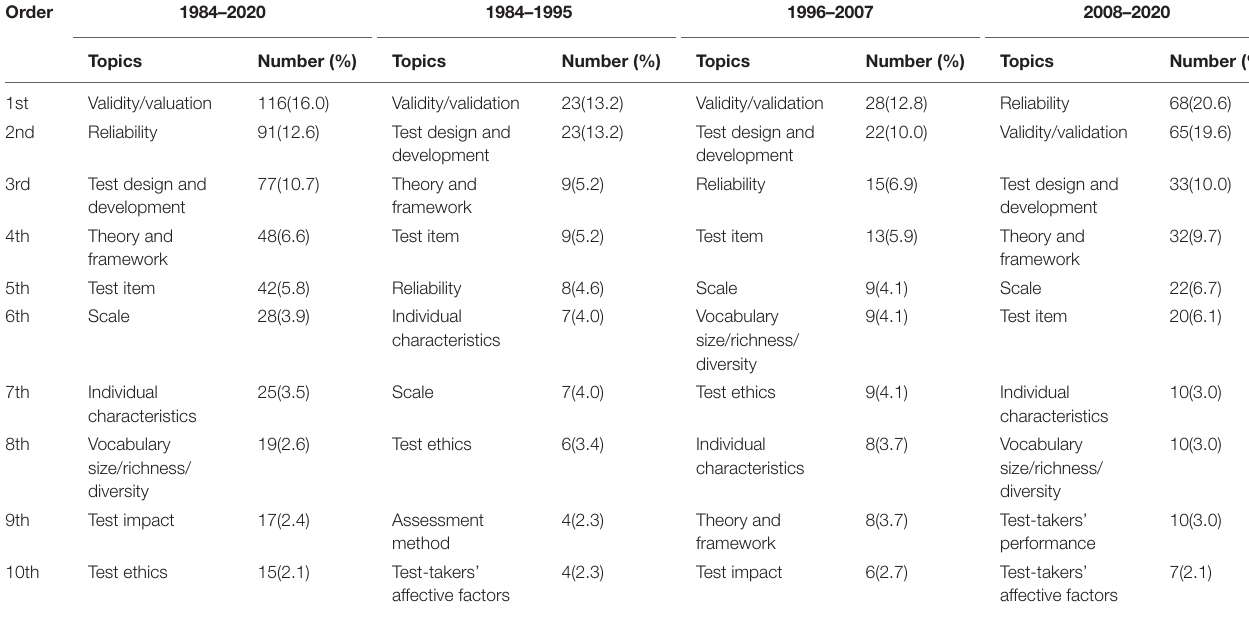
TABLE 3 | Top 10 most frequently discussed research